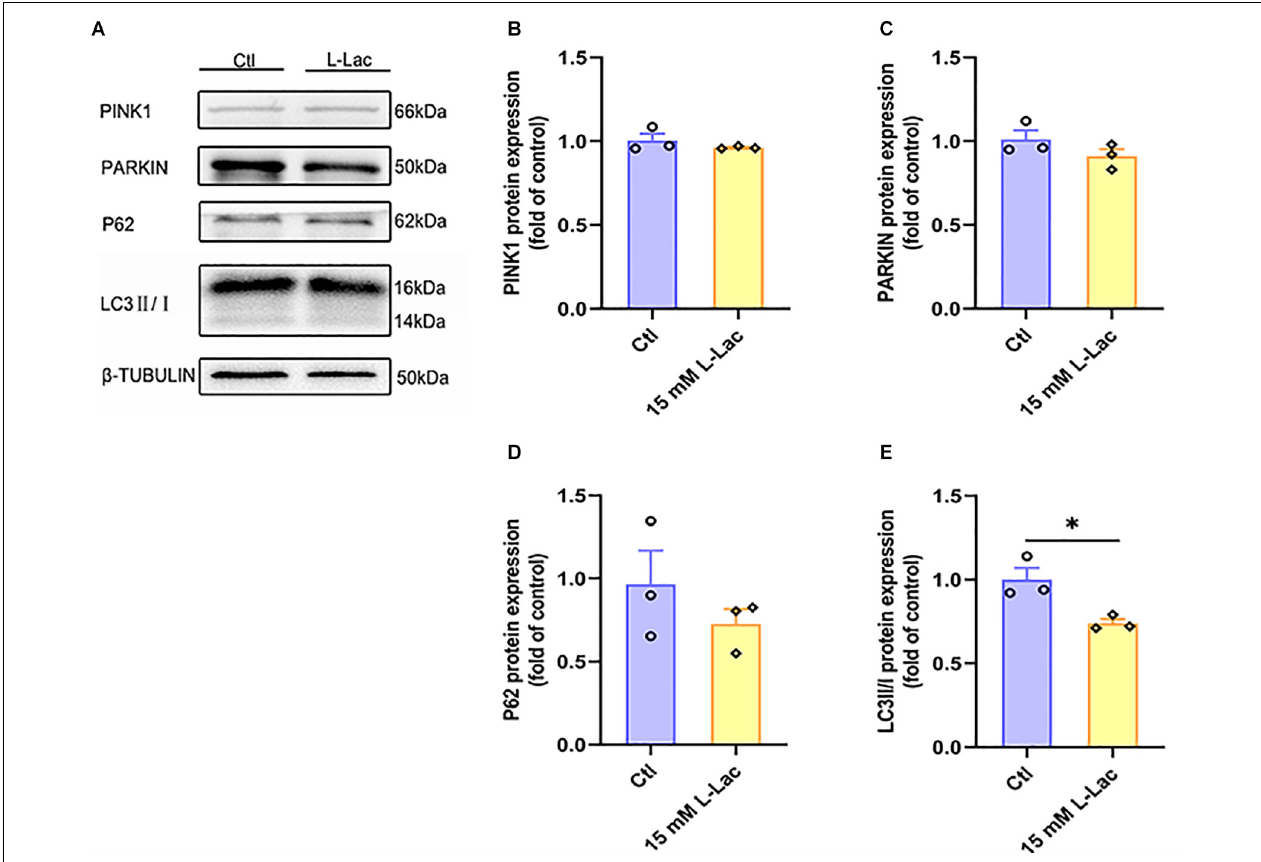
FIGURE 10 | Lactate weakly influenced mitophagy in primary hippocampal cells. The PTEN-induced putative kinase 1 (PINK1), PARKIN, Sequestosome-1 (P62), and microtubule-associated protein light chain3 (LC3) were determined by WB to observe the effect of lactate on the mitophagy in primary hippocampal cells. (A) Representative WB image. (B) PINK1 protein expression. (C) PARKIN protein expression. (D) P62 protein expression. (E) LC3 protein expression. TUBULIN as the loading control. N = 3 in three independent experiments. ∗ P ≤ 0.05 as compared with the Ctl group by non-parametric tests. Values are expressed as mean ± standard error of the